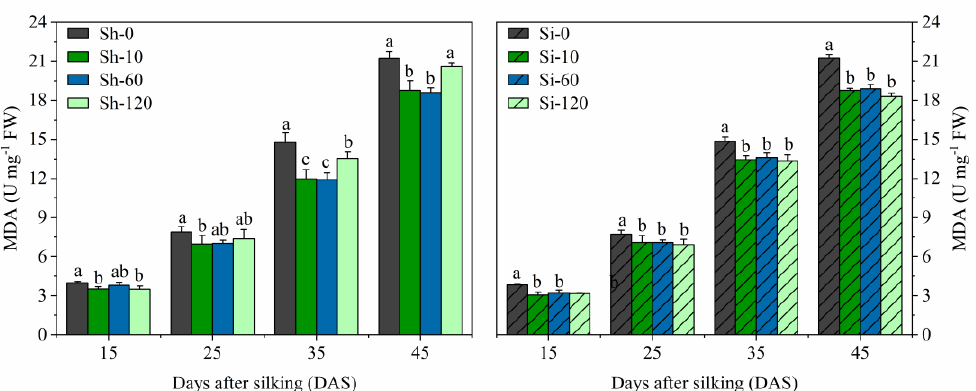
Figure 5. E ff ects of GA 4 + 7 applications on MDA content in maize. Sh-0, Sh-10, Sh-60 and Sh-120 represent shank-treatments with GA 4 + 7 at the rates of 0, 10, 60, and 120 mg L − 1 , respectively. Si-0, Si-10, Si-60 andSi-120 represent silk-treatments with GA 4 + 7 at the rates of 0, 10, 60, and 120 mg L − 1 , respectively. The vertical bars represent the ± the standard error of the mean (n = 3).